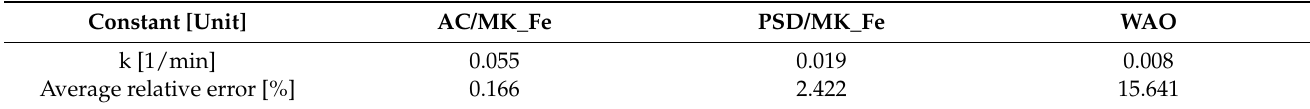
Figure 5. Bisphenol A conversion as a function of time for AC/MK_Fe and PSD/MK_Fe catalysts. Operating conditions: p (air): 20 bar, c (BPA): 60 mg/L, c (cat): 1 g/L, 800 rpm, T: 160 °C. Table 3. The rate constant and average relative error for the CWAO and WAO.